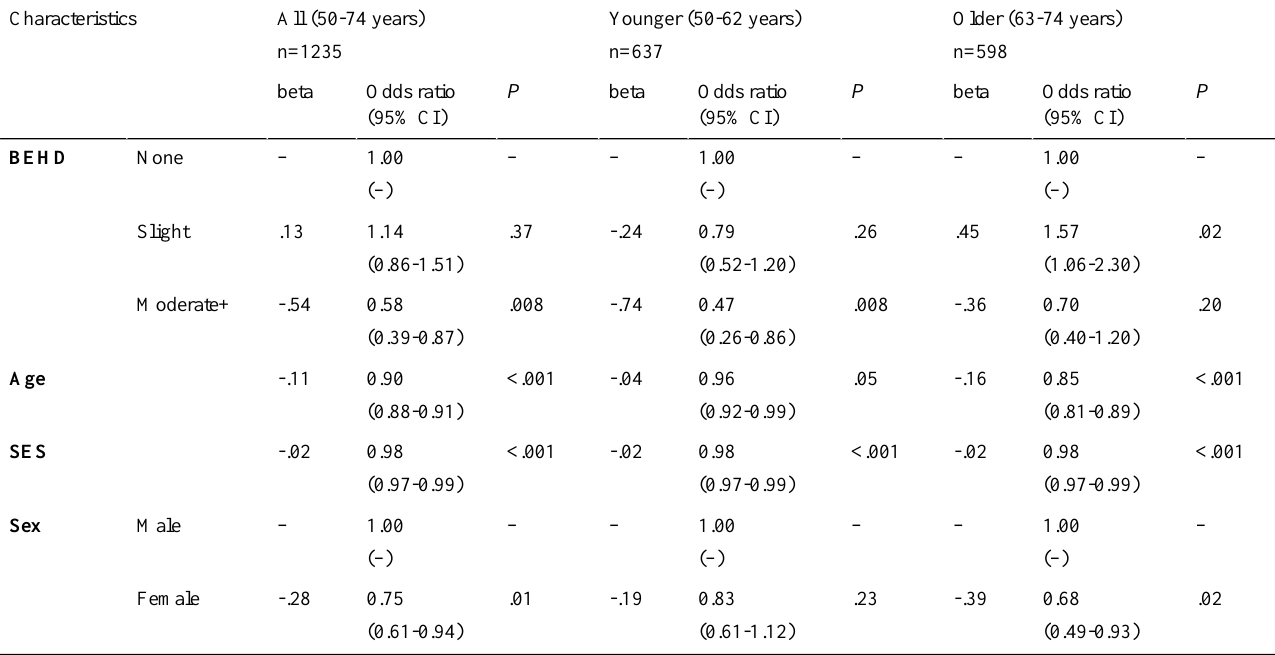
Table 3. Logistic regression coefficients (beta) and odds ratio estimates from the multivariate ordinal logistic regression models for factors affecting PC skill